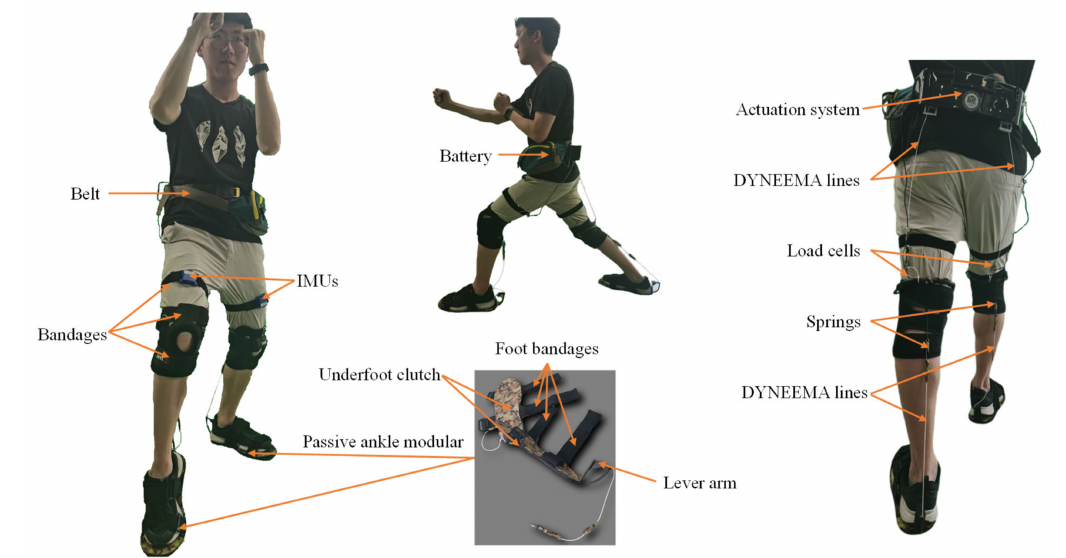
Figure 1. The mechanism and prototype of the proposed soft lower limb